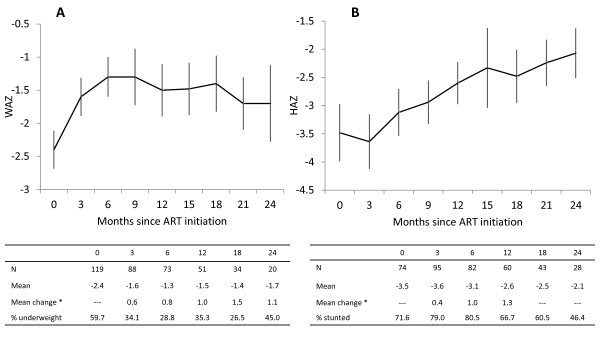
Mean (95% CI) weight-for-age (A) and height-for-age (B) z-scores by time since ART initiation. *sample sizes are smaller due to missing data at ART initiation